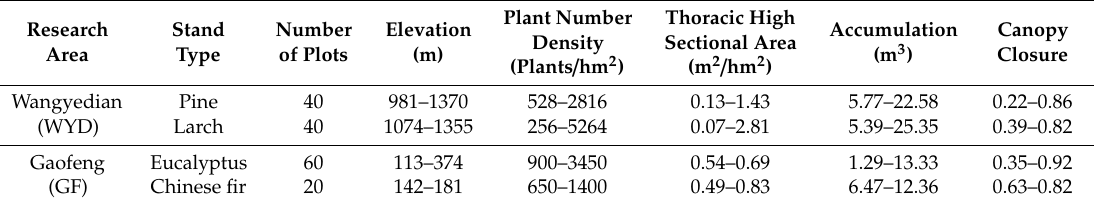
Table 2. Statistics of canopy closure (CC) plots in the two study areas.